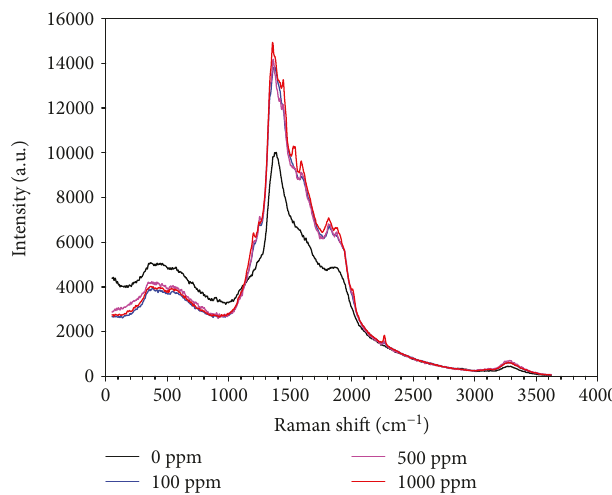
Figure 6: Evolution of the Raman spectra of doped chitosan fi lms with di ff erent concentrations of nanoparticles.